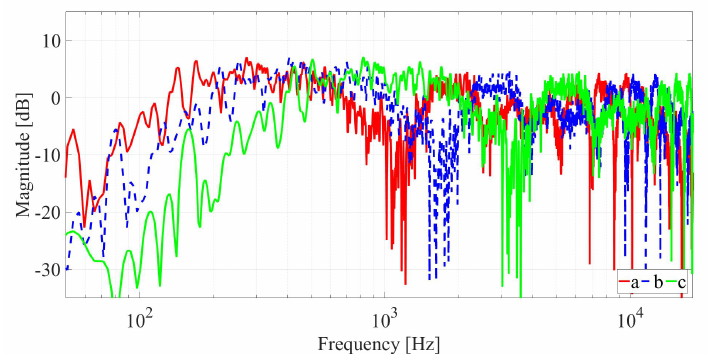
Figure 5. Frequency warping of a measured RTF: ( a ) RTF; ( b ) warped RIR with λ = 0.2; ( c ) warped RIR with λ = 0.5.